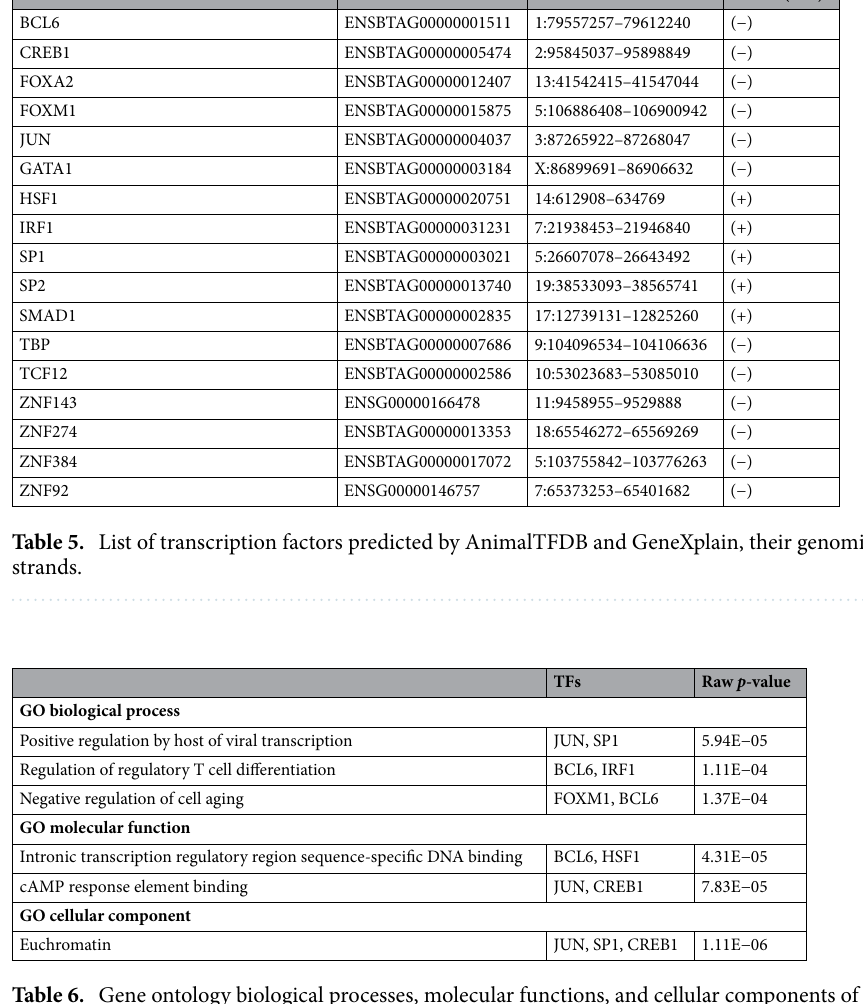
Table 6. Gene ontology biological processes, molecular functions, and cellular components of predicted TFs.